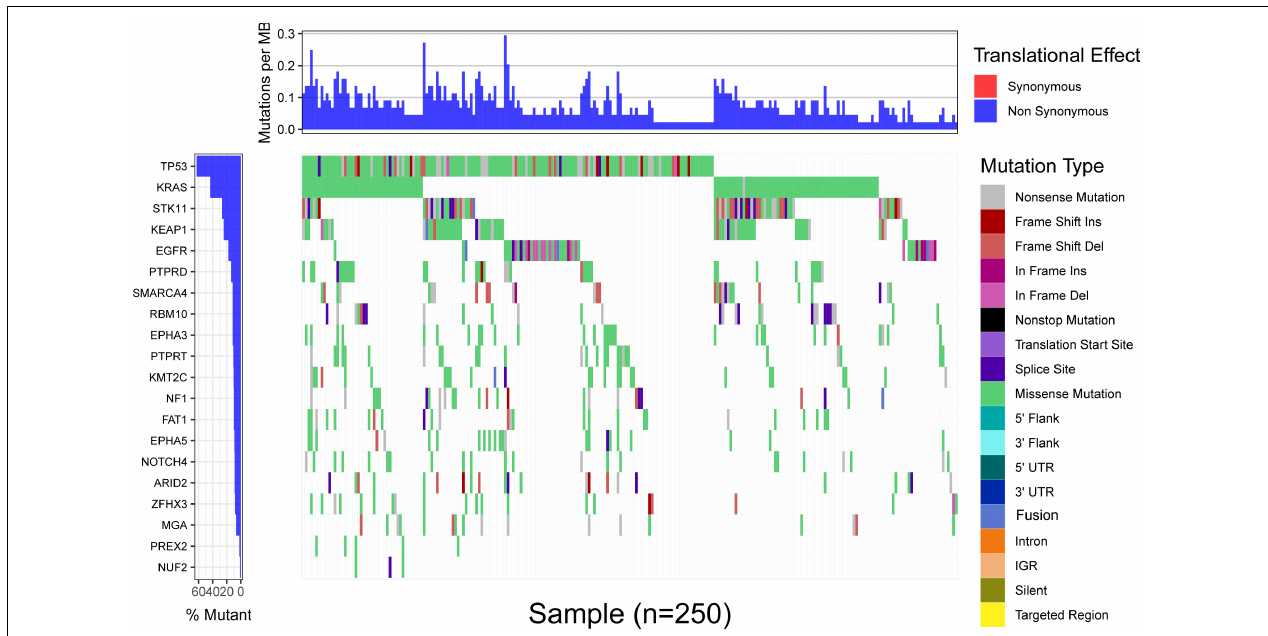
FIGURE 7 | The landscape of the top 20 frequently mutated genes in 271 LUAD patients of the MSKCC cohort. The upper portion is the translational effect, synonymous or non-synonymous. The first row of the lower portion indicate the gene names and the mutant frequency, the second row indicate the mutation type of each mutation in each sample, and the right figure depicts genes mutation types (marked with different